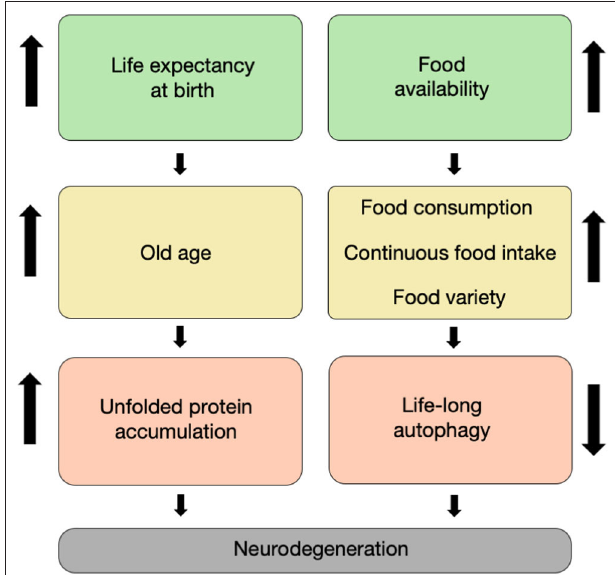
FIGURE 1 | It takes age and food to degenerate. The increased life expectancy at birth witnessed throughout the last two centuries has led to an increase in the proportion of elderly in the population, which is characterized by unfolded proteins and non-functional organelle accumulation within neurons (left column). Concomitantly, the increase in food availability during the second half of the twentieth century led to an increase in food varieties, consumption, and intake. This has led in turn to a decrease in life-long autophagy flux in cells, including neurons (right column). Both of these routes have synergized to result in a large increase in the prevalence of neurodegenerative disorders that we currently